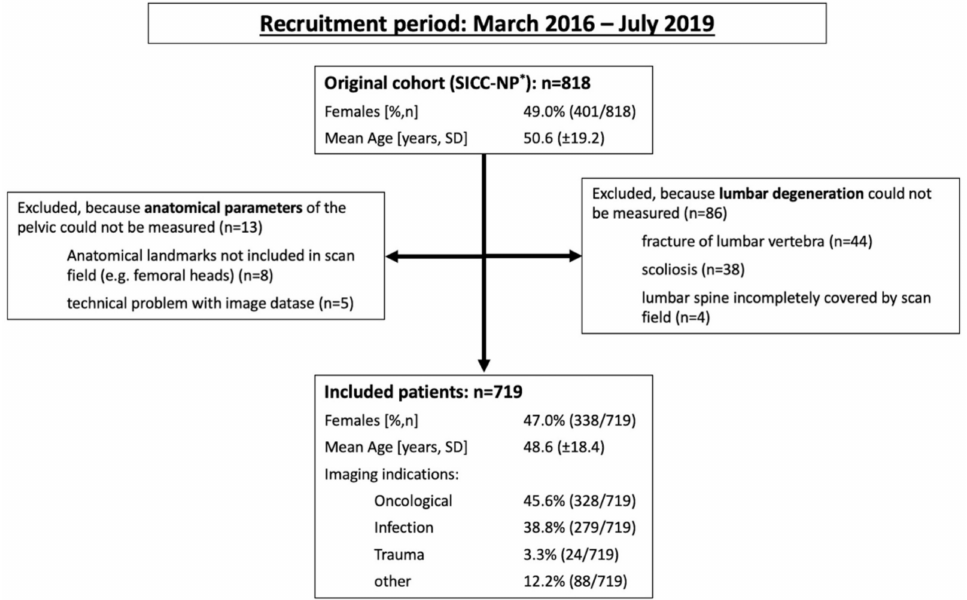
Figure 1. Patient flow. SICC-NP* = sacroiliac changes in the normal population study [12].